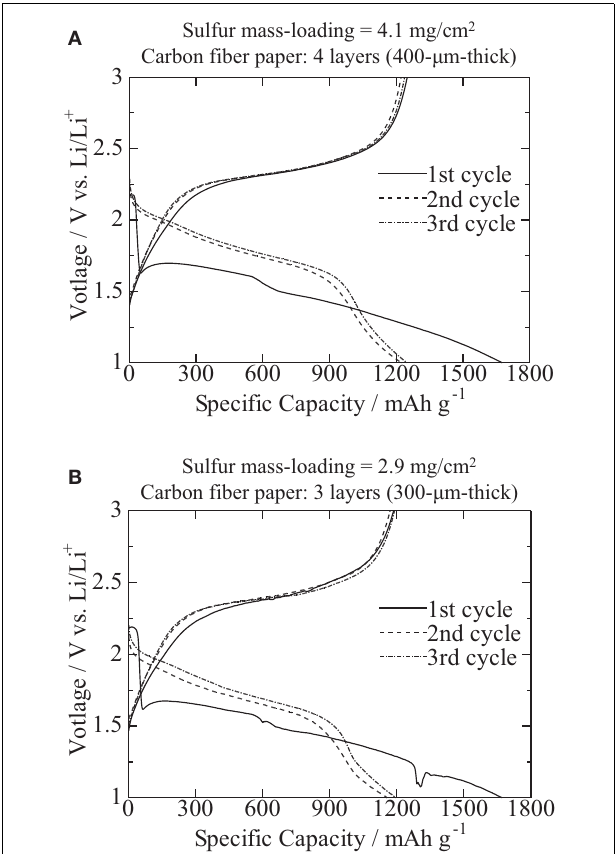
FIGURE 1 | Voltage profiles of the first to the third cycles at 0.2C . Specimens were composed of the S/PAN/KB-based cathodes with (A) a cathode composite mass-loading of 11mg/cm 2 (sulfur, 4.1mg/cm 2 ; carbon fiber paper, 400 µ m thick) and (B) a cathode composite mass-loading of 7.7mg/cm 2 (sulfur, 2.9mg/cm 2 ; carbon fiber paper, 300 µ m thick) that were cast into carbon fiber papers, and lithium foils as anodes.